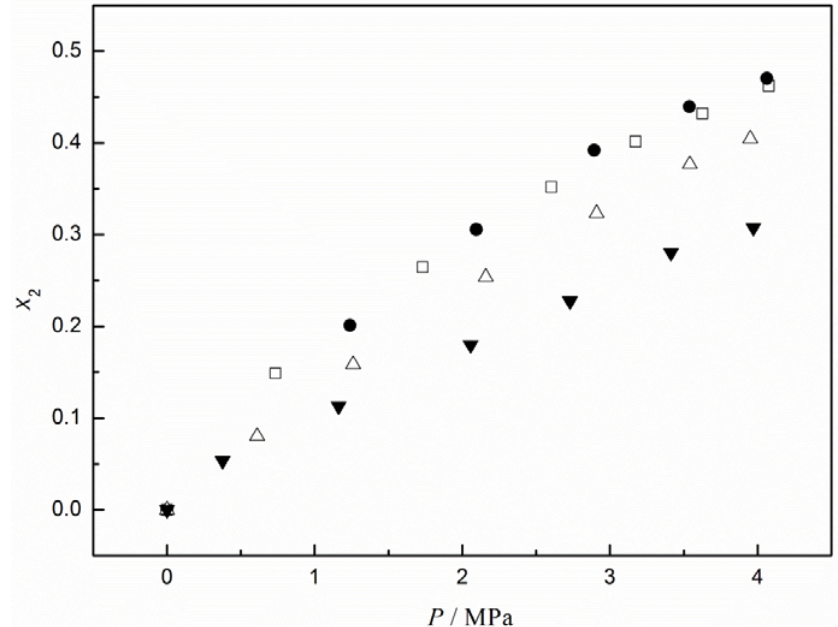
Table 1. Experimental solubility values, expressed as the mole fraction x